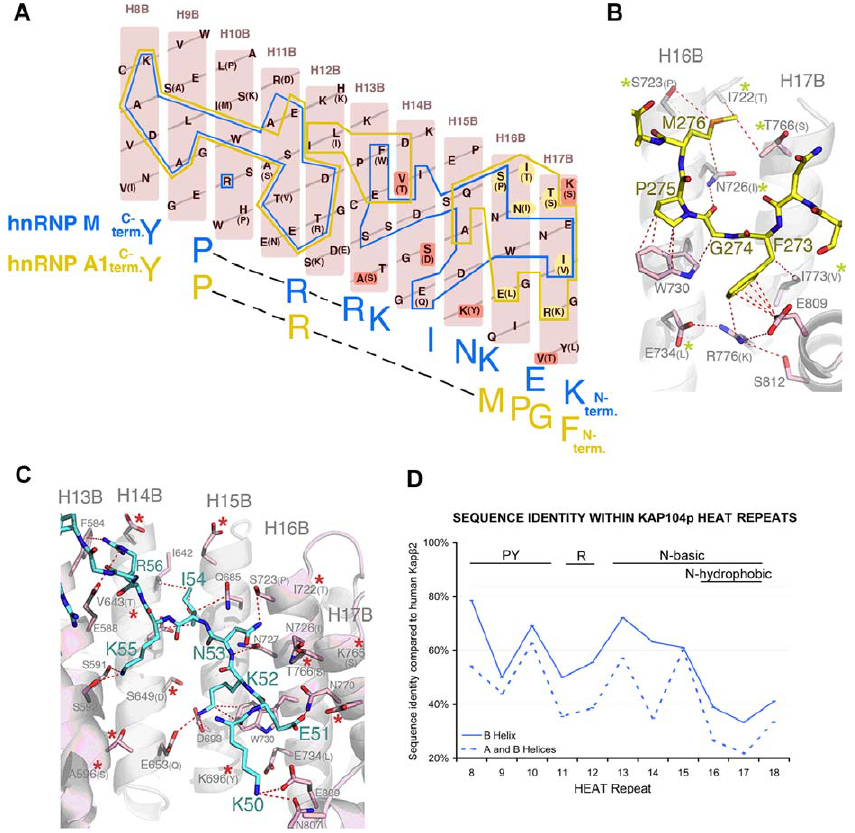
Figure 3. Kap b 2–NLS Structures and Kap104p Specificity (A) Schematic representation of the Kap b 2–NLS interface showing B helices of Kap b 2 H8–H17 (pink). Residues that are different in Kap104p are in parentheses. Kap b 2 residues that contact the hnRNP A1 NLS (hPY-NLS) and the hnRNP M NLS (bPY-NLS) are outlined in yellow and blue, respectively. Residues contacting the N-terminal FGPM hydrophobic motif in hnRNP A1, which are also different in Kap104p, are highlighted in yellow. Residues that increase electronegativity of the Kap104p surface are highlighted in red. (B) Interactions between Kap b 2 (pink) and the N-terminal hydrophobic motif of hnRNP A1 (yellow) (PDB ID 2H4M) drawn with PYMOL [67]. Residues that are different in Kap104p are in parentheses (yellow asterisks label residues that may affect interactions with hPY-NLSs). (C) Interactions between Kap b 2 (pink) and the N-terminal basic motif of hnRNP M (blue) (PDB ID 2OT8). Residues that are different in Kap104p are in parentheses. Red asterisks label Kap104p substitutions that increase electronegativity. (D) Sequence identity within individual HEAT repeats of Kap b 2 and Kap104p. The motifs recognized by the B helix of each HEAT repeat are specified above the